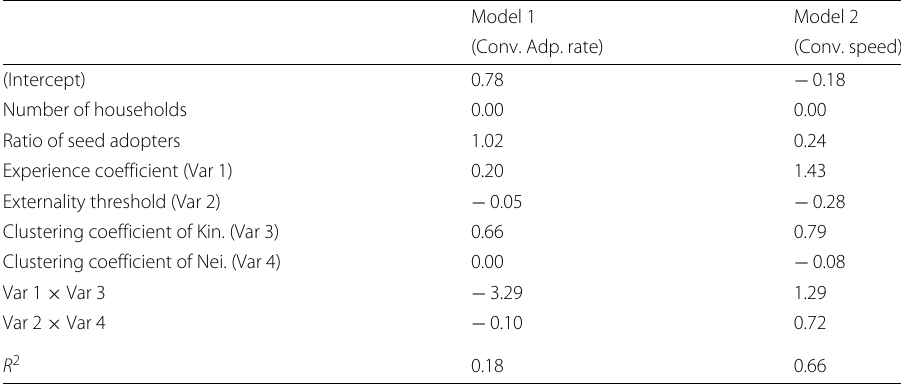
Table 8 Regressions of convergence adoption rate and convergence speed on clustering coefficient (negative externality effect) Model 1 Model